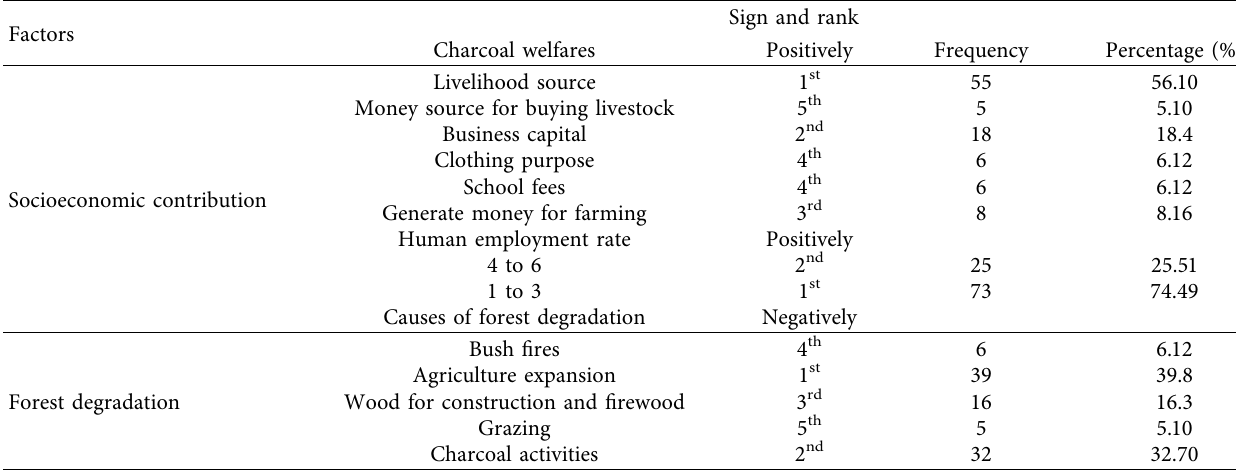
Figure 5: Charcoal transportation and marketing system in Ofa woodlands. source: survey data (feld photos by author Table 3: Charcoal production and its associated socioeconomic contribution and forest degradation according to the producer’s answer in Ofa Woreda ( n � 98).